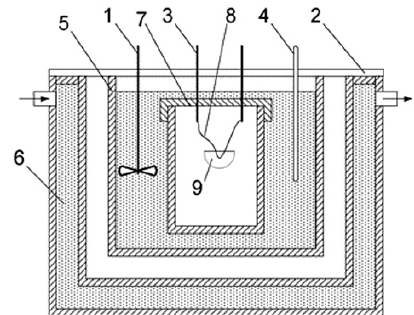
Fig. 4. Calorimeter parts: 1 – mixer for uniform mixing of water; 2 – jacket cover; 3 – fuse cables; 4 – water